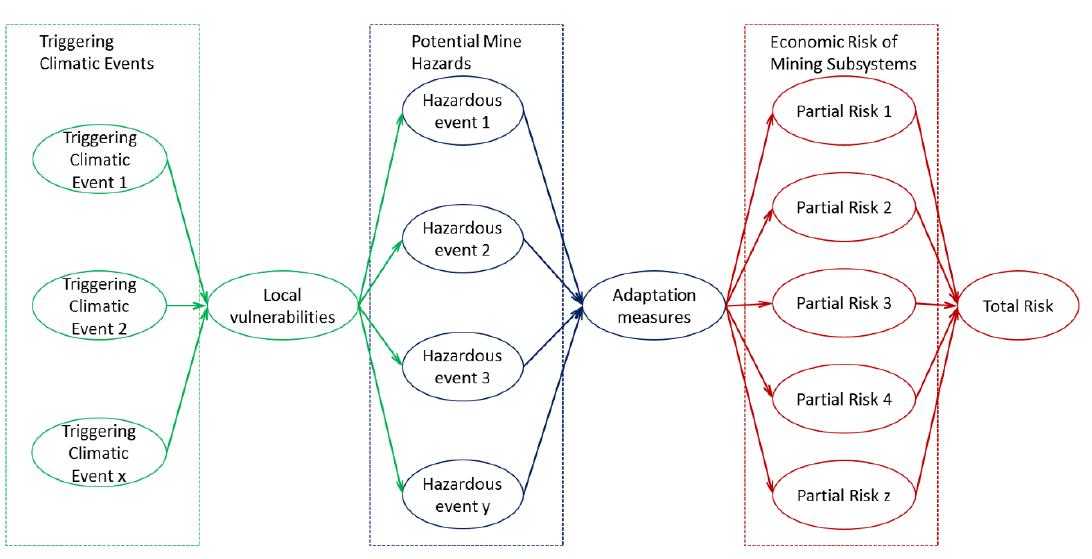
Figure 1. Conceptual model of CLImate Change Economic Risk in the Mining Industry (CLIRMI).